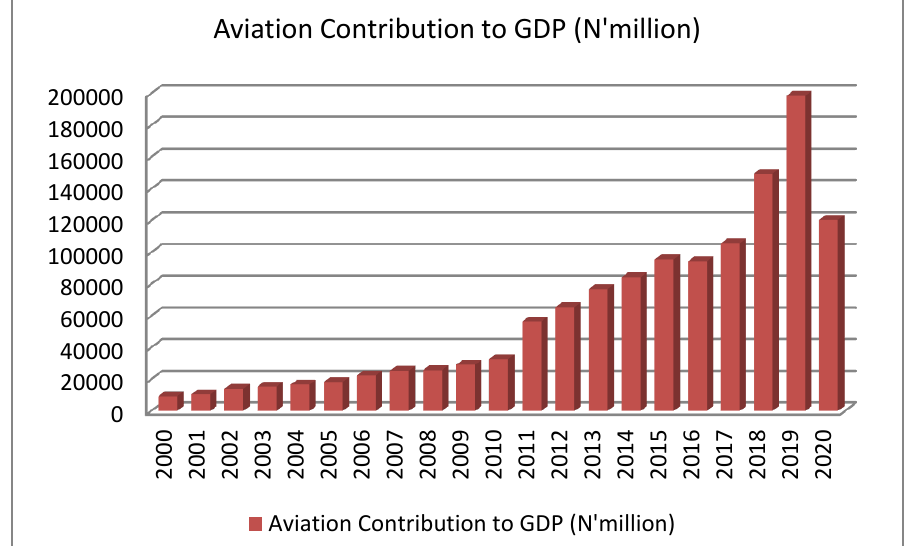
Figure 2 . Aviation contribution to GDP.